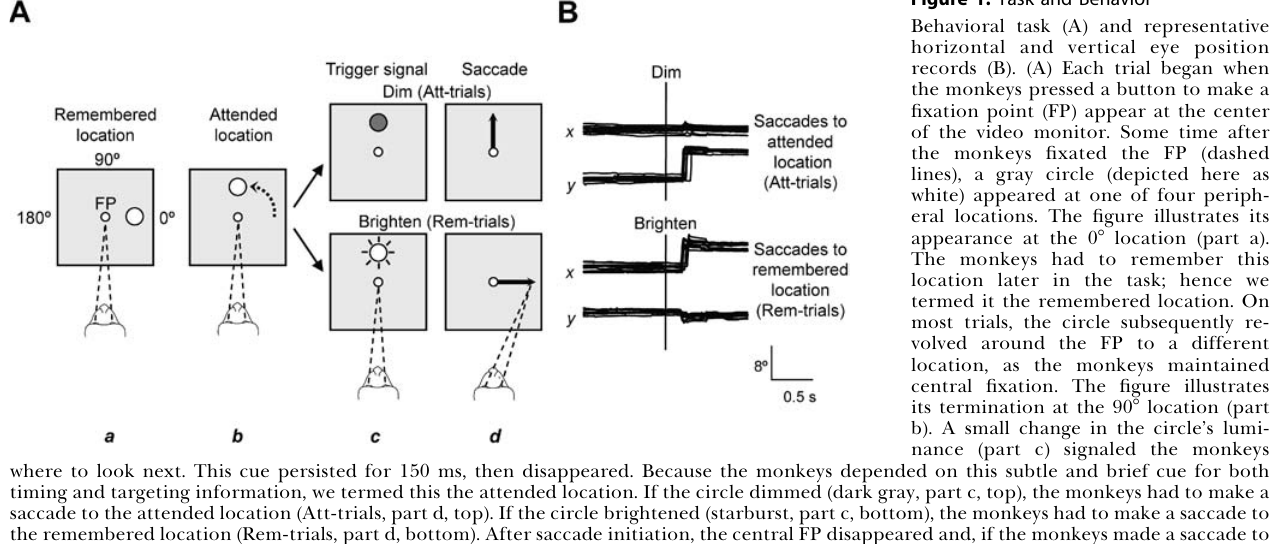
Figure 1. Task and Behavior Behavioral task (A) and representative horizontal and vertical eye position